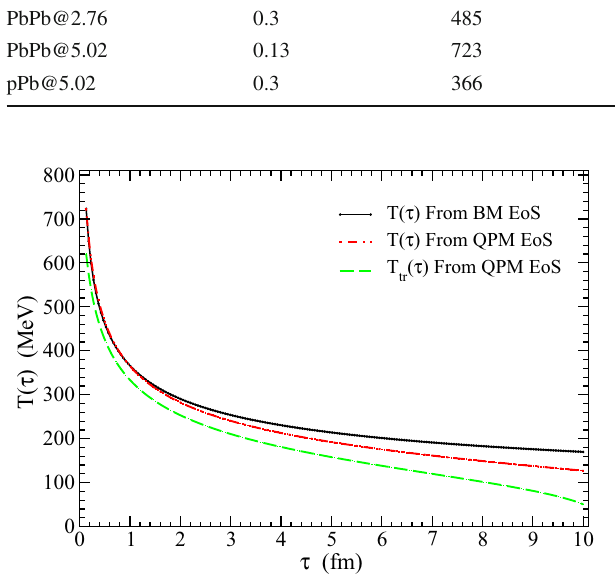
Table 2 We obtained the initial temperature, T 0 , using initial (thermalization) time ( τ 0 ) and QGP lifetime ( τ QGP ) for T c = 170 MeV, corresponding to collision system and their respective center of mass collision energy √ s NN (TeV)